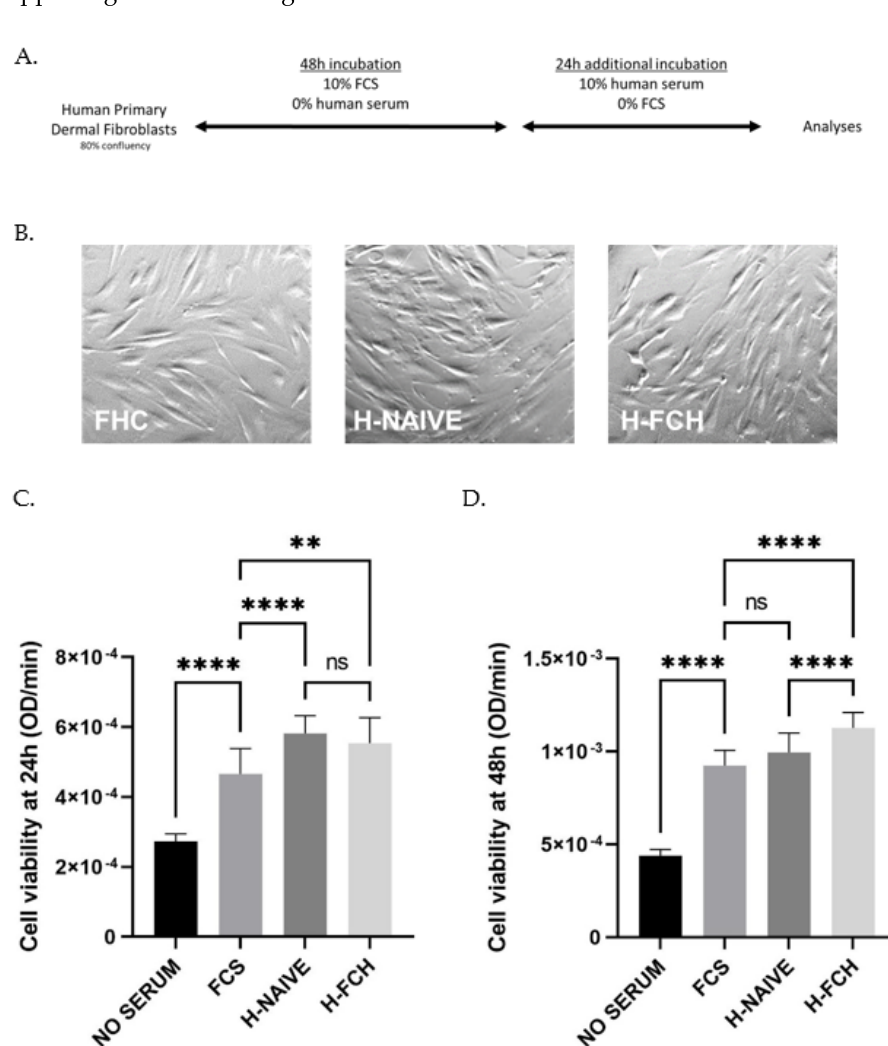
Figure 3. Primary human dermal fibroblasts (adult) subjected to ex vivo procedures ( A ). Regular fibroblastic shape upon human serum incubation ( B ). Cell viability measured with an XTT ‐ based assay upon either FCS or human serum incubation (H ‐ NAIVE for human naive serum and H ‐ FCH for human serum enriched with circulating FCH metabolites) for 24 h and 48 h ( C , D ). Measures were performed in quadruplicates per condition/volunteer ( n = 10 volunteers). Values are presented as the means ± SD. The differences were considered statistically significant at p < 0.05 with ** for p < 0.01; **** for p < 0.0001 and ns for p >